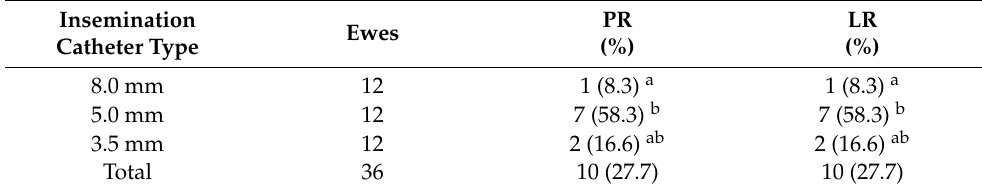
Table 1. Pregnancy (PR) and lambing (LR) rates of ewes submitted to transcervical artificial insemination by three different catheters.